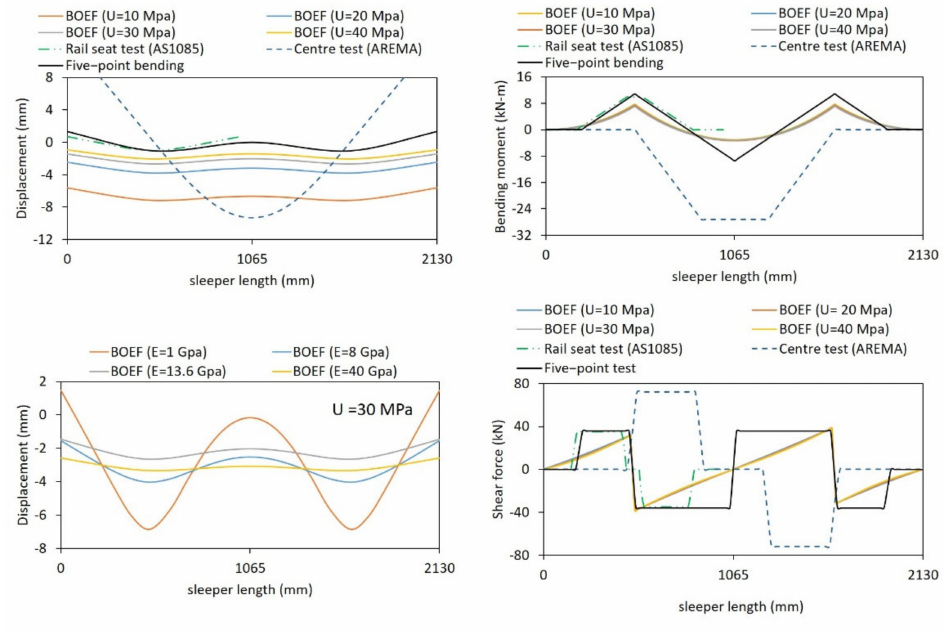
Figure 5. Sleeper behaviour according to BOEF theory, five-point bending, rail seat and centre